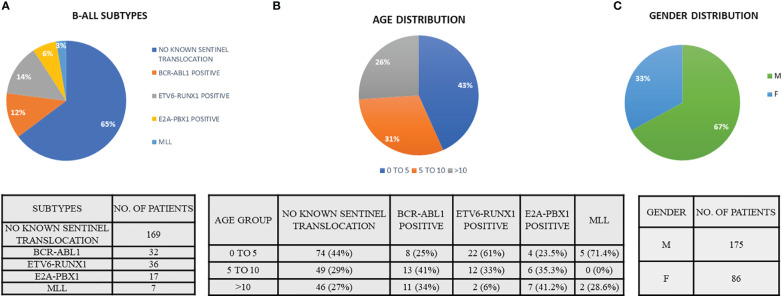
Demographic data indicating the (A) B-ALL subtypes, (B) age distribution of B-ALL patients, and (C) gender distribution. (Patient data reported from March 2016 to August 2019).